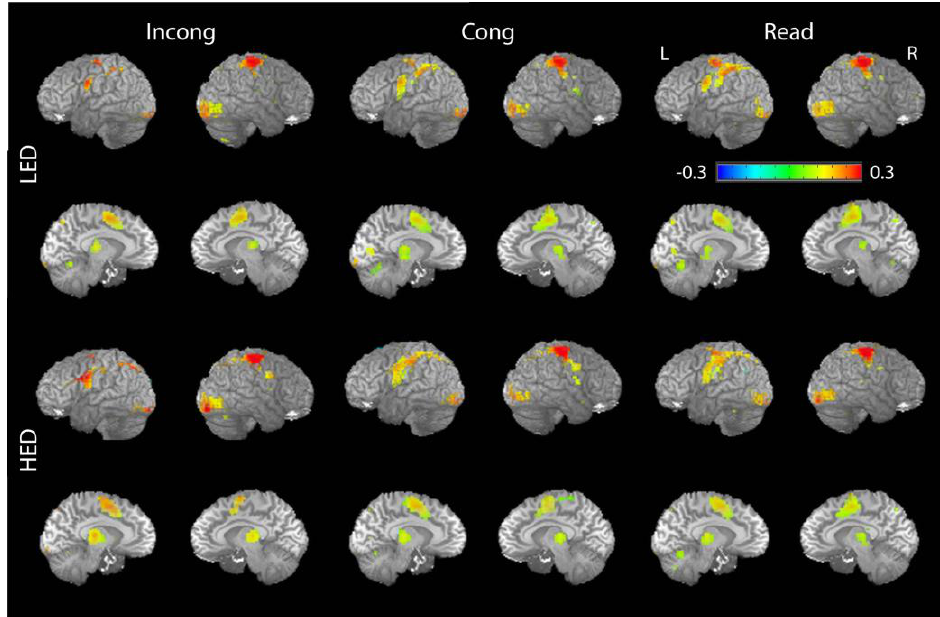
Figure 3. Lateral and medial views of group averaged activity for heavy (HED) and light episodic drinkers (LED) across task conditions at 4 s post stimulus. Voxel threshold was set at p = 0.001 with a false discovery rate (FDR) value of q = 0.003, t = 3.725. The color scale represents voxels with percent signal change coefficients between −0.3 and 0.3 that survive the threshold obtained from mixed-effects meta-analysis (MEMA).